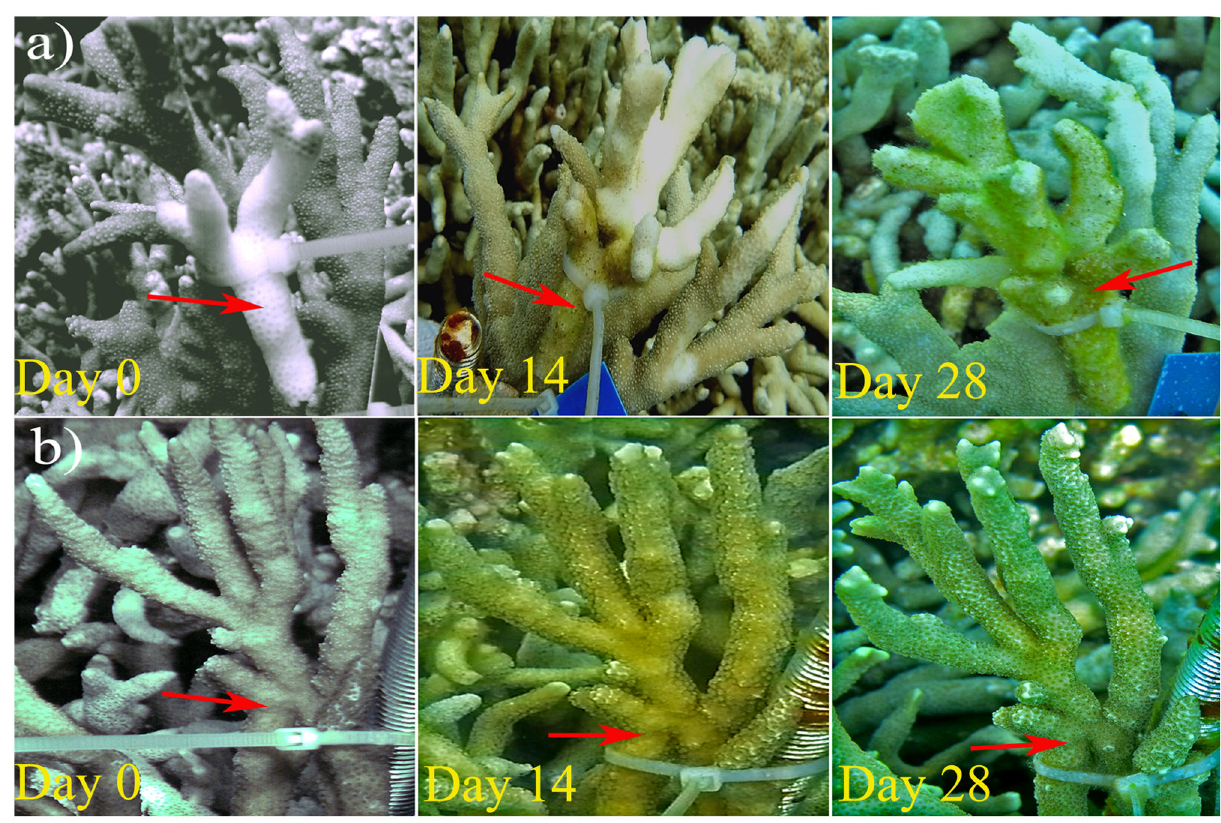
Figure 2. Transmission experiment of PAWS in the field. The donors are indicated by the red arrows. At initial setup (Day 0) of the treatments (a), healthy fragments in direct contact with diseased P. andrewsi fragments were healthy; no replicates had yet responded five days later; 14 d later, the P. andrewsi fragments in direct contact with diseased P. andrewsi and nearby fragments were infected; 28 d later, additional P. andrewsi fragments were also diseased. However, the control (b) P. andrewsi fragments in direct contact with healthy P. andrewsi were healthy during the entire experimental